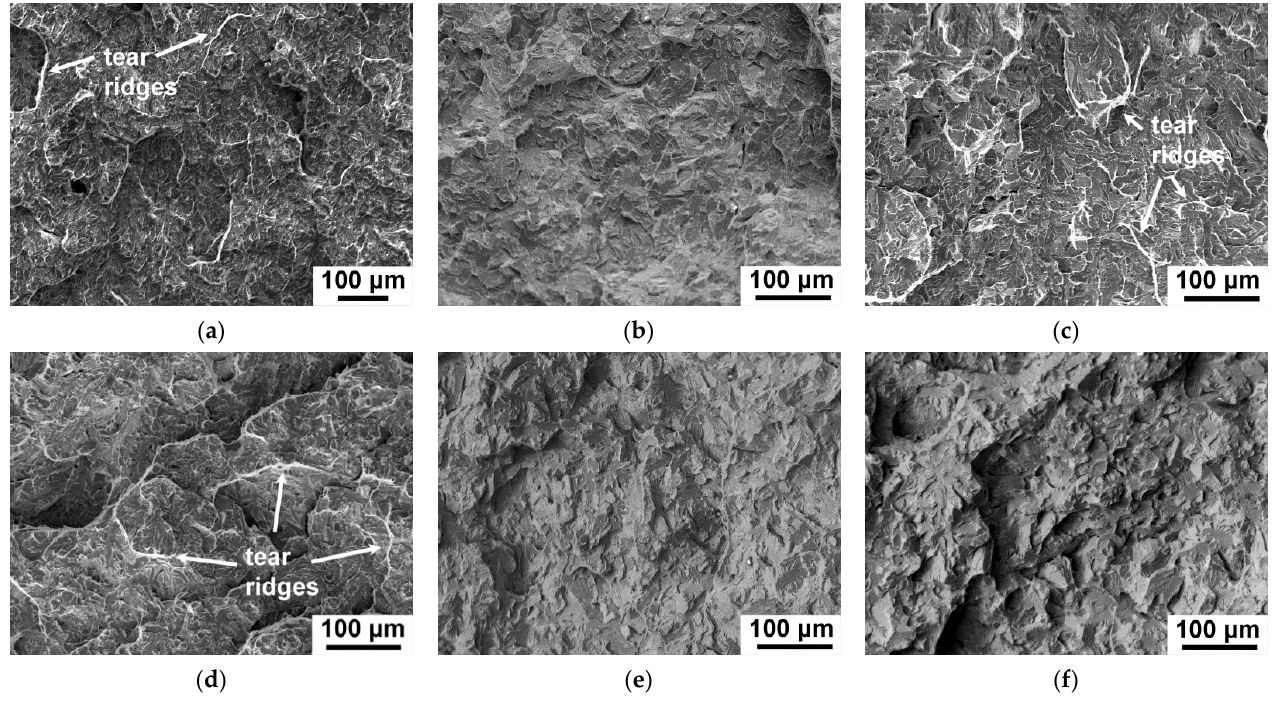
Figure 3. Fractography of the fractured surfaces in the unstable crack propagation zone of the 12CrTaNb0.003N ( a , d ), 12CrNb0.003 ( b , e ), and 12CrTaNb0.02 ( c , f ) steels subjected to the CHT ( a – c